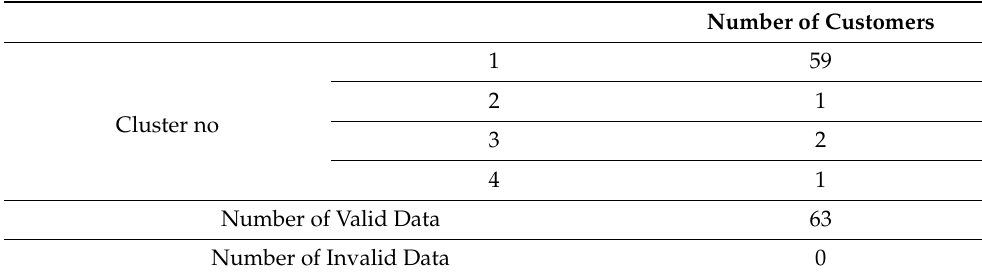
Table 6. Number of customers at any cluster, account deficit error (source: research analysis).